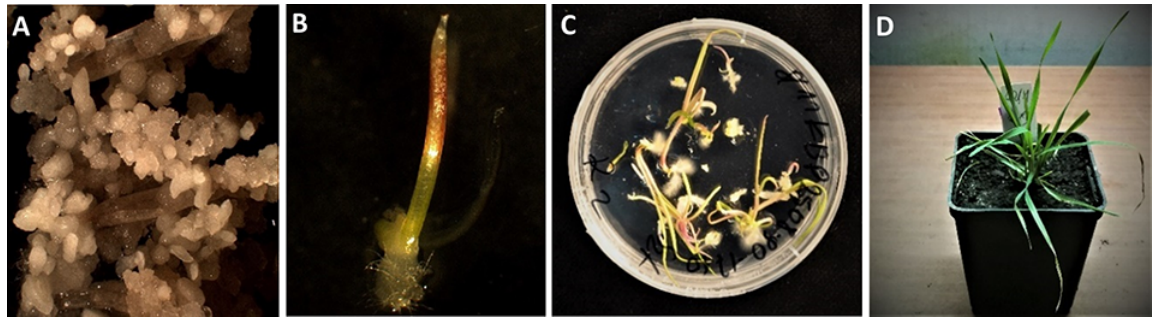
Figure 5 Illustration of rye androgenesis from callus with androgenic ELS to regenerated plant. ( A ) Embryogenic callus and clearly differentiated embryos and ELS. ( B ) Germinating androgenic embryo. ( C ) Green plantlets on regeneration medium. ( D ) Rooted DH of